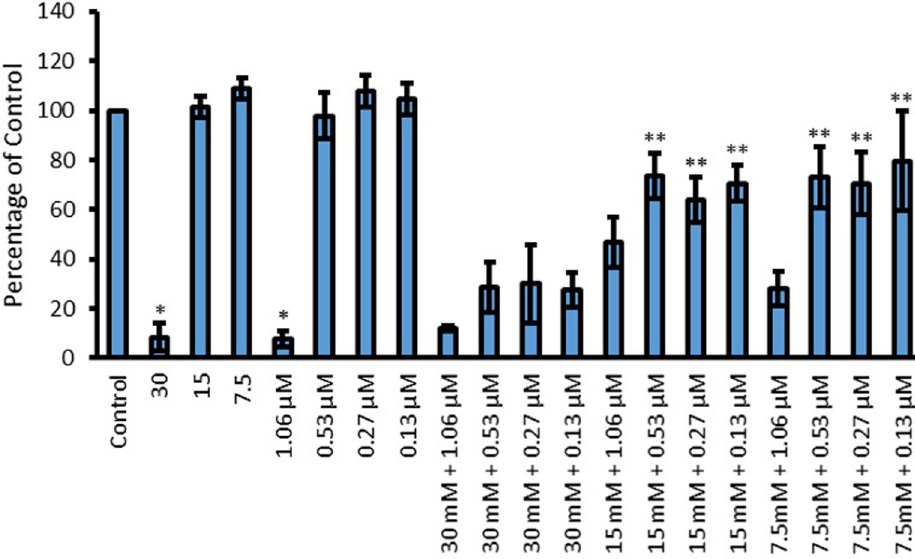
Fig 11. Effect of L-Asp, Cip and L-Asp and Cip combinations on the production of pyoverdine by P . aeruginosa . Y-axis shows concentration of pyoverdine as a percentage of untreated, when treated with 30, 15 and 7.5 mM L-Asp, 1.06, 0.53, 0.27 and 0.13 μ M Cip and their combinations. Significant results are indicated by � or �� , where � represent a significant reduction in pigment production by the amino acid or Cip compared to control and �� represents a significant reduction in pigment production by combinations (AA + Cip) compared to both of the individual corresponding components (p < 0.05 was taken as significant); n = 3.